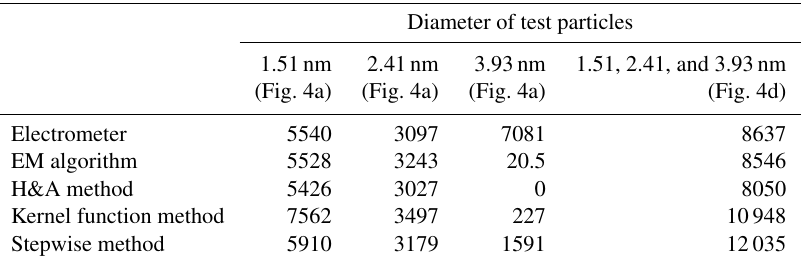
Table 1. The inverted particle concentrations (in cm − 3 ) using different inversion methods and the total particle number concentration (in cm − 3 ) recorded by the Faraday cage electrometer when measuring monodisperse